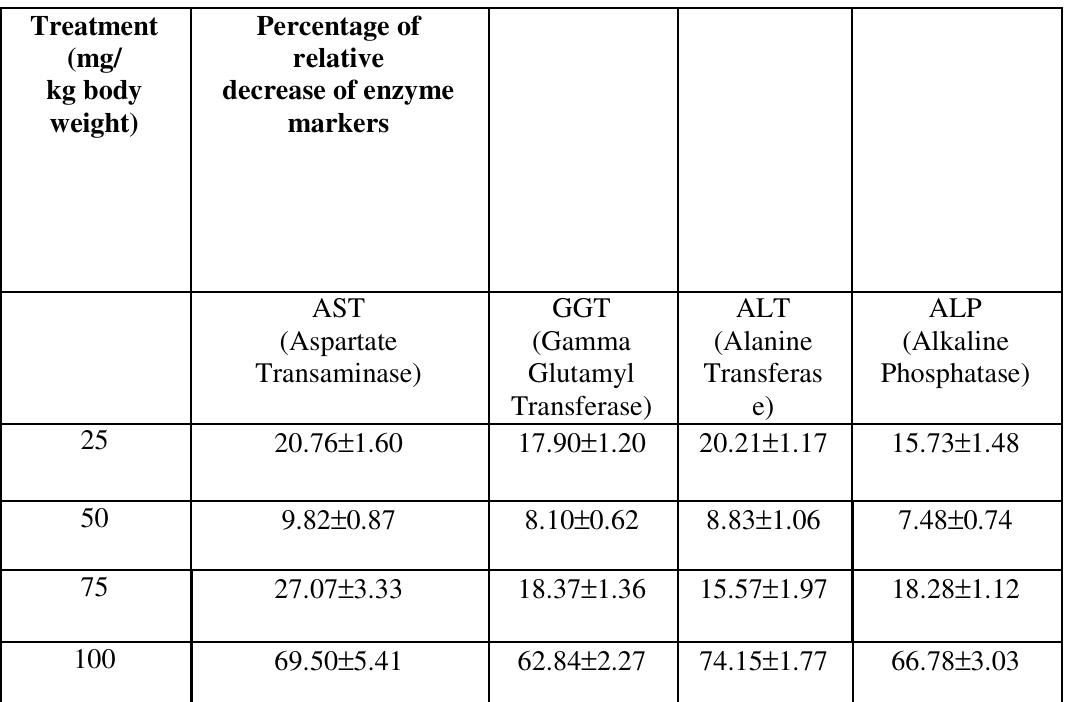
Table 3: Percentage of hepatoprotection offered by ethanol extract of leaf of Cajanus Indicus Spreng in respect of liver marker enzymes